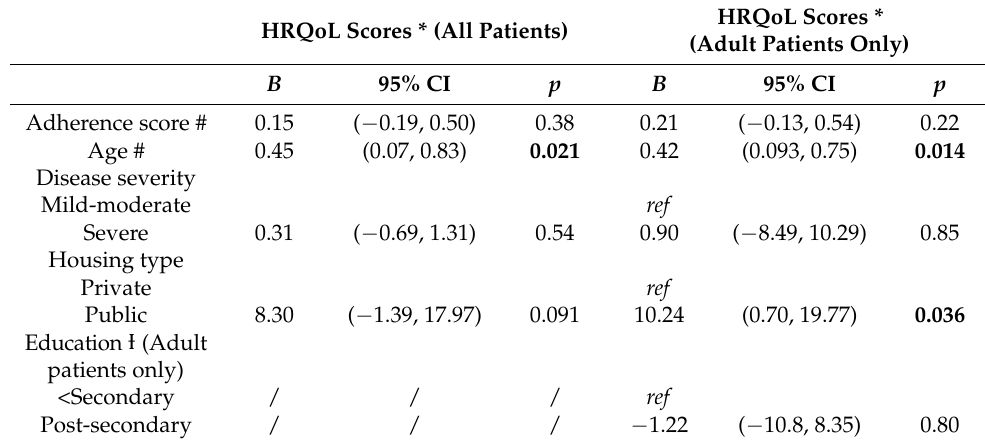
Table 5. Exploratory Multivariable Analysis of Factors Associated with Health-related Quality of Life. Table 2. Summary and Univariate Comparison of Health-related Quality of Life Outcomes